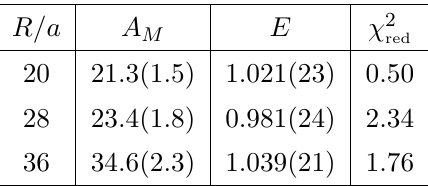
Table 3 . Results of the two-parameter fits of the data shown in the right-hand-side panel of figure 4 to eq.